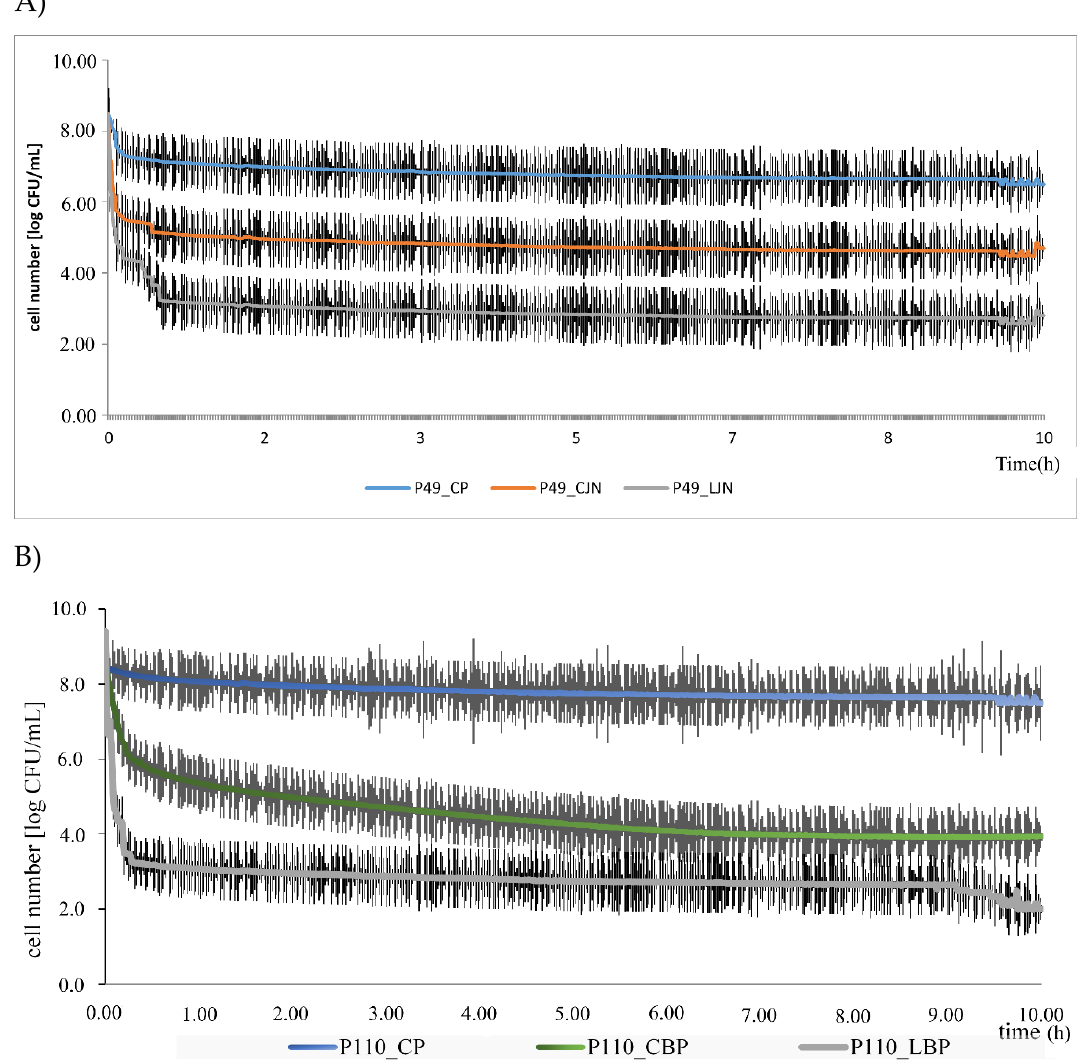
Figure 1. Bacteria growth curve with and without essential oils in Minimal Inhibitory Concentration (MIC) levels ( A ) P49 strain, juniper oil; ( B ) P110 black pepper oil; CP—control probe, CJN—commercial juniper oil, LJN—laboratory juniper oil, CBP—commercial black pepper oil, LBP—laboratory black pepper